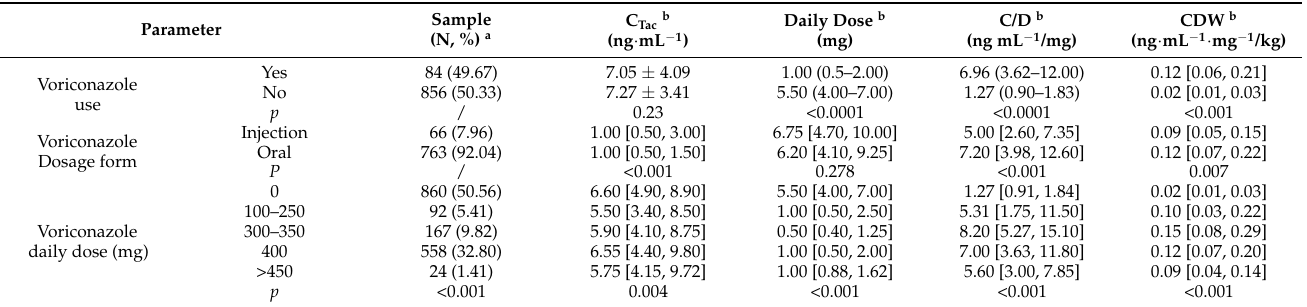
Table 4. Effects of voriconazole use, dose, and dosage form on daily dose, CTac, C/D, and CDW of